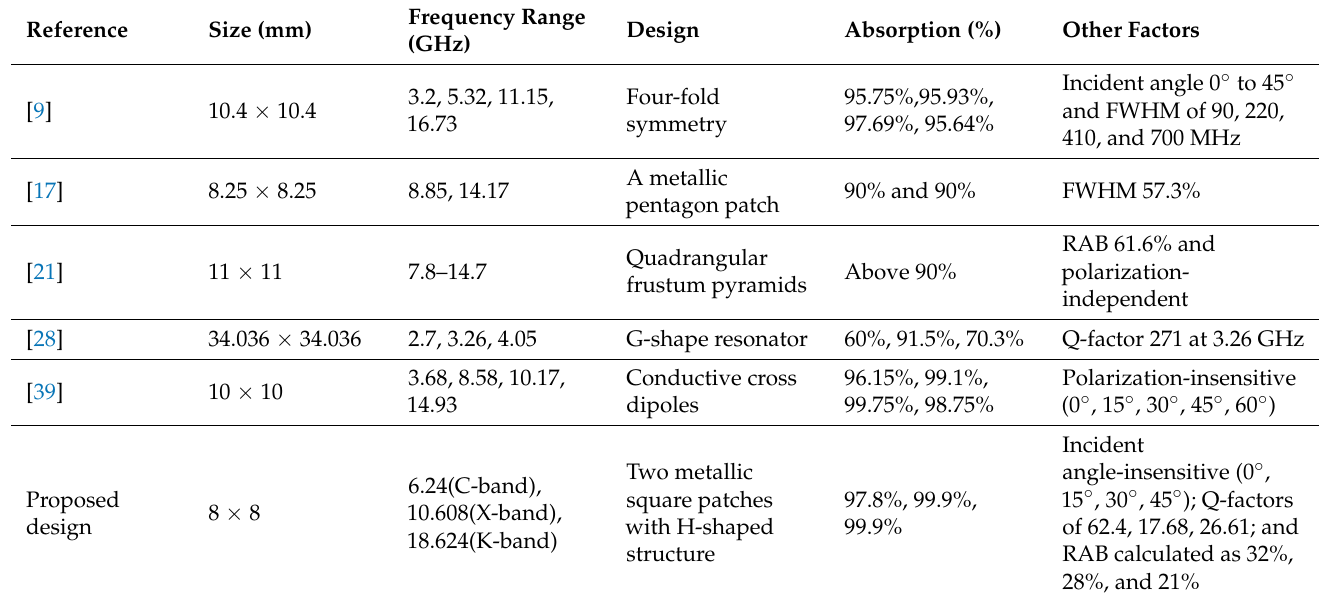
Table 3. Comparison table of proposed MAs in the previous literature.